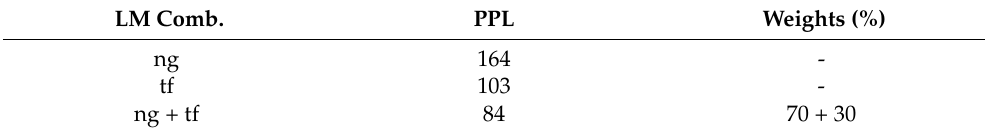
Table 6. Perplexity (PPL) and interpolation weights, computed over the dev1-dev set, of the n-gram (ng) and Transformer (tf) LMs and their combination when trained with restricted data. LM Comb.